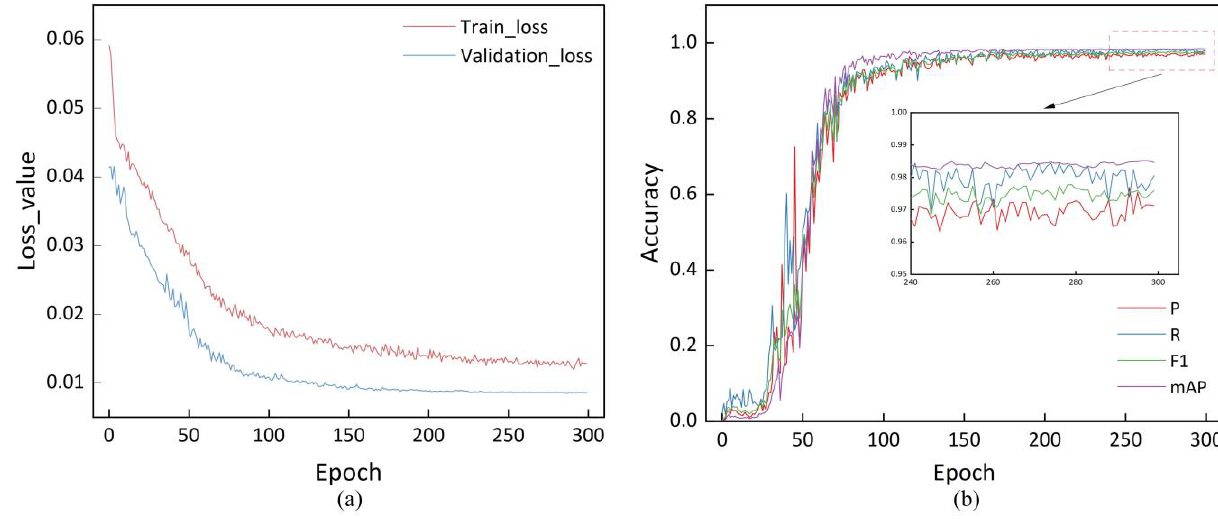
Figure 7. Training process of the improved Yolov5s: ( a ) training and validation loss; ( b ) validation curve of accuracy.